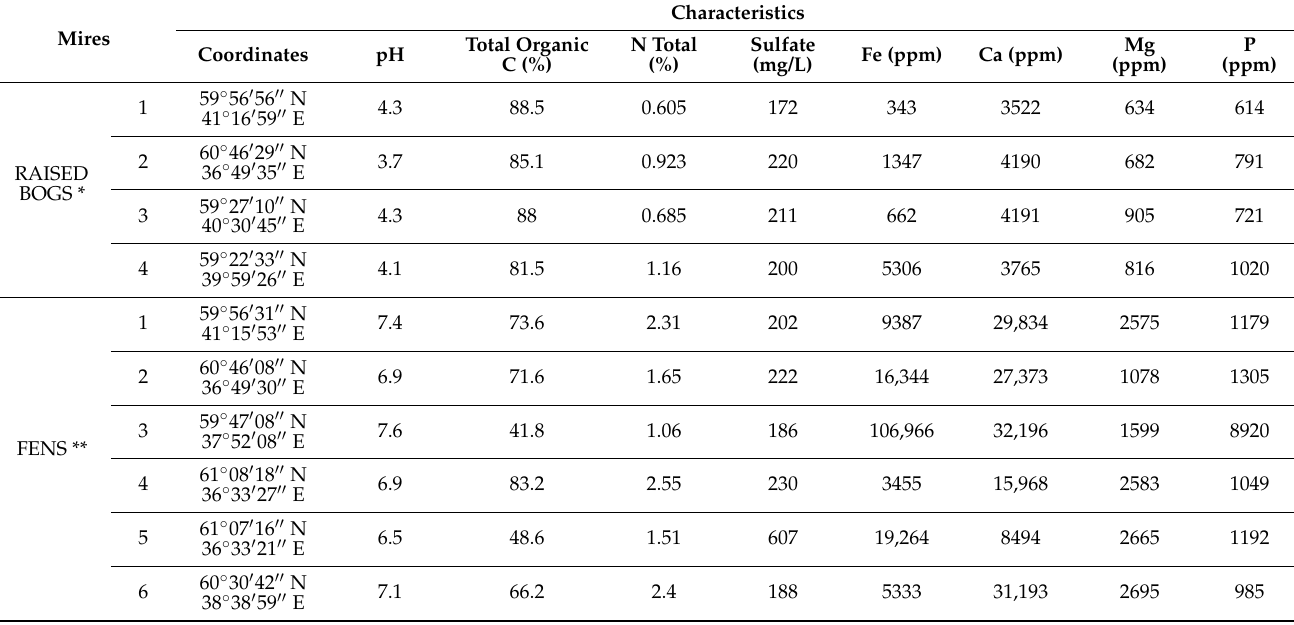
Table 1. Characteristics of the peatlands examined in this